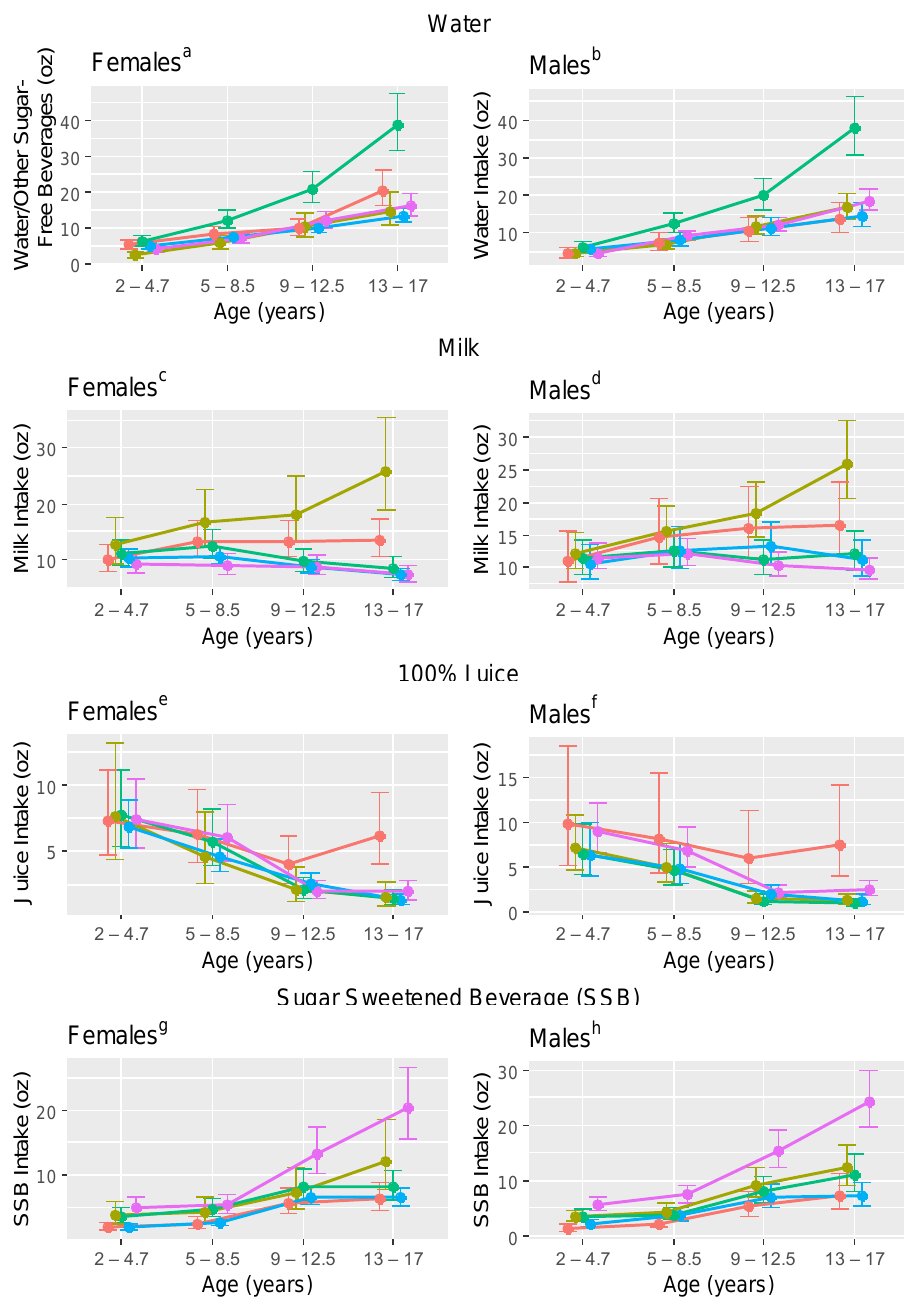
Figure 1. Age 2 – 4.7, 5 – 8.5, 9 – 12.5 and 13 – 17 year i mean j (95% confidence interval; CI) daily beverage intakes of age 13 – to 17 – year Iowa Fluoride Study beverage clusters ( n = 369; 193 female and 176 male). Red – 100% Juice Cluster, Gold – Milk Cluster, Green – Water, Blue – Neutral (no dominant beverage) Cluster, Purple – Sugar-Sweetened Beverage Cluster. a,b Model-based mean water/SFB intakes and 95% CIs for females and males in each beverage cluster. c,d Model-based mean milk intakes and 95% CIs for females and males in each beverage cluster. e,f Model-based mean 100% juice intakes and 95% CIs for females and males in each beverage cluster. g,h Model-based mean SSB intakes and 95% CIs for females and males in each beverage cluster. i All values represent the same approximate age; points are shifted for ease of reading. j Model-based mean estimates. In order to satisfy the positivity assumption of the gamma distribution, 0.001 was added to all observations to avoid outcome variable values of 0.